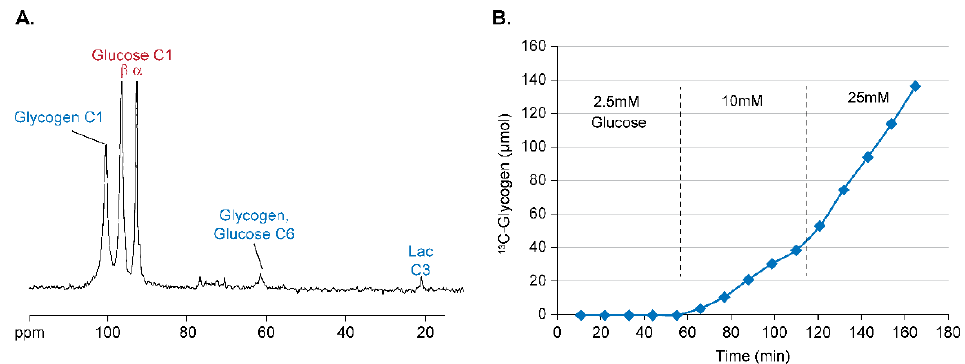
Figure 4. The measurement of 13 C-glycogen synthesis from [1- 13 C] glucose. ( A ) 13 C NMR spectrum from a perfused liver after 50 min of metabolizing 20 mM of [1- 13 C] glucose. The end products [1- 13 C] glycogen, [6- 13 C] glycogen, and [3- 13 C] lactate are observed. ( B ) The time course of [1- 13 C] + [6- 13 C] glycogen for a single liver presented with different perfusate concentrations of [1- 13 C] glucose. Reprinted from reference [11] .